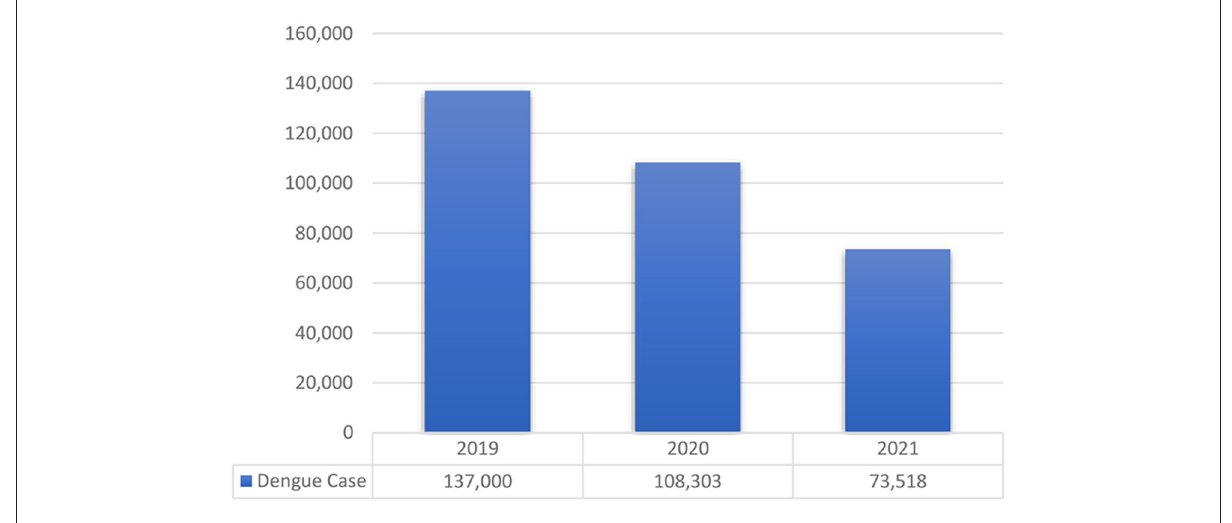
FIGURE1 Dengue case in Indonesia